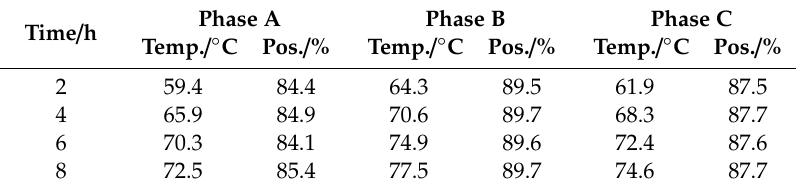
Table 4. The hotspots information of LV winding during the operating time.